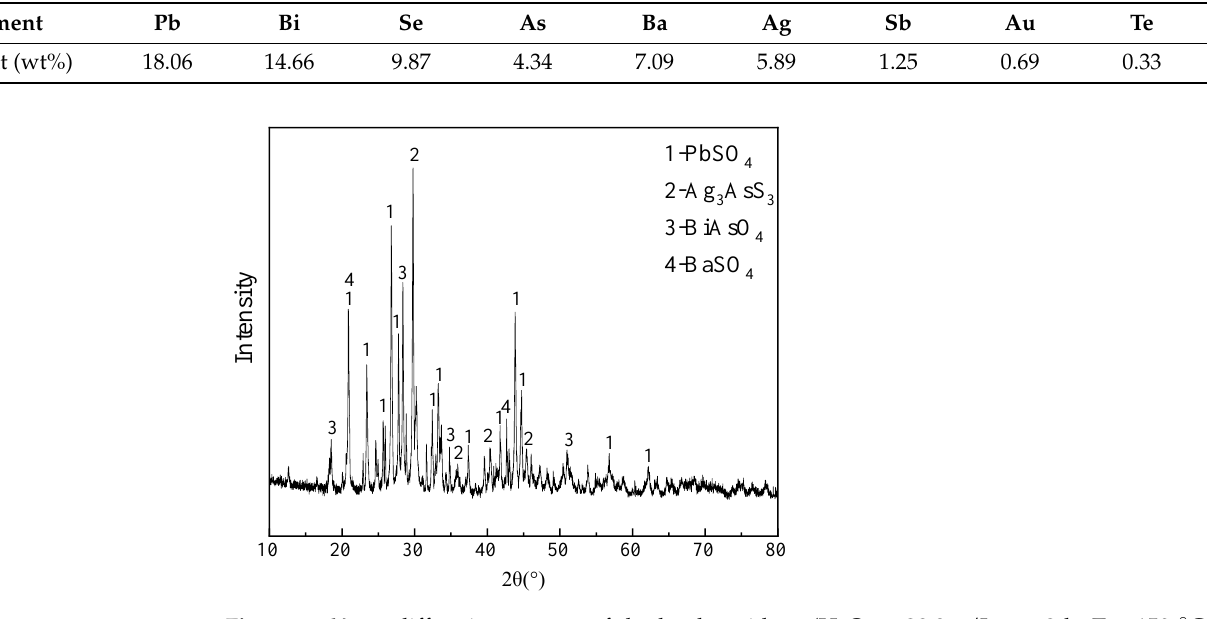
Figure 9. X-ray diffraction pattern of the leach residues (H 2 O 2 = 28.8 g/L, t = 2 h, T = 150 °C, P = 0.8 MPa and H 2 SO 4 = 250 g/L).